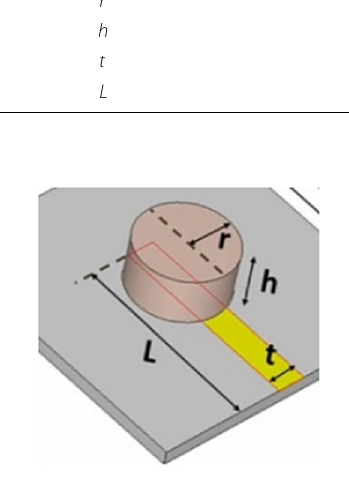
Fig. 3 Design of